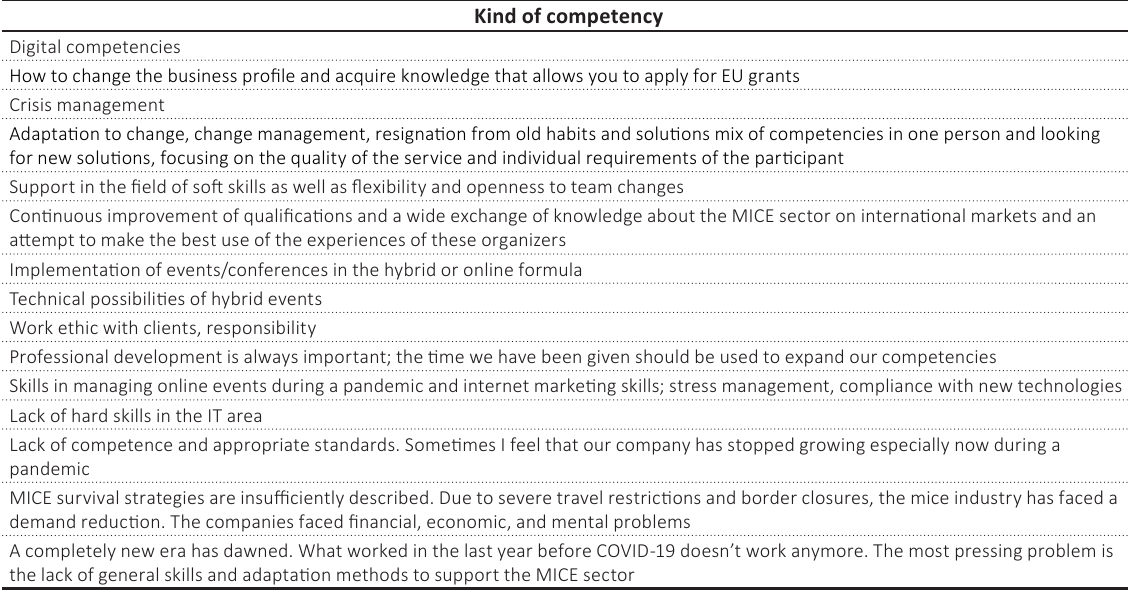
Source: Own study.